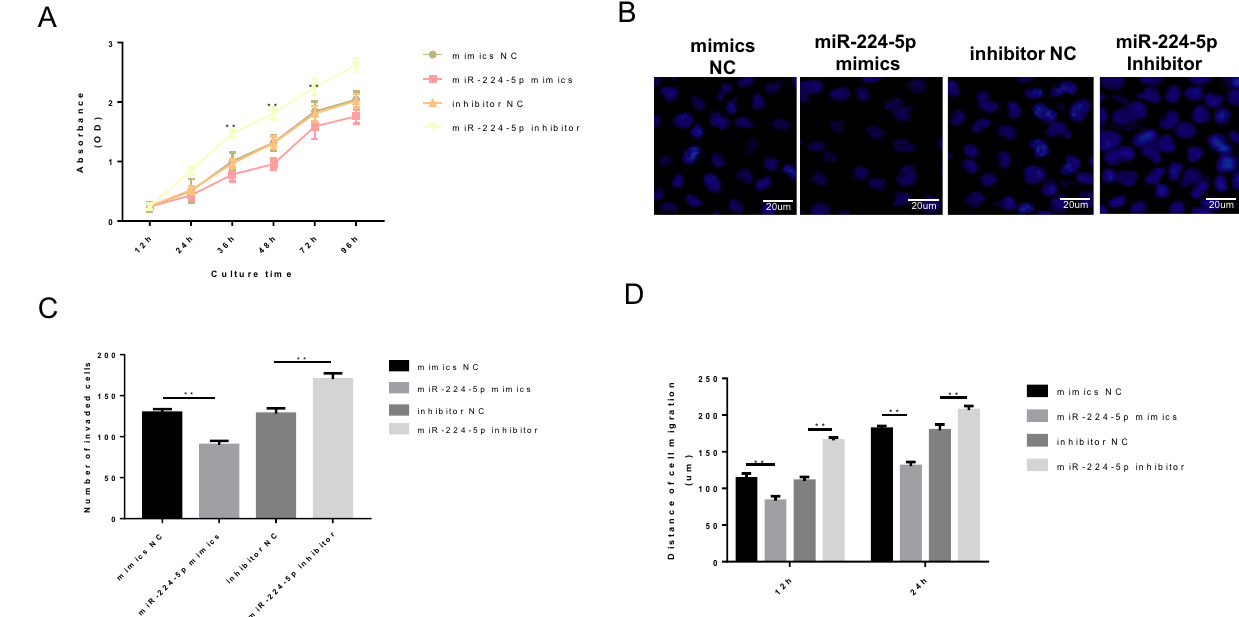
Figure 3. miR-224-5p inhibited the proliferation, migration and invasion of osteosarcoma cells via downregulating Rab10. ( A ) Cell proliferation was tested by the Cell Counting Kit-8 assay. ( B ) Cell invasion was detected by the Transwell assay. ( C ) Number of invading cells. ( D ) Cell migration was detected by the wound healing assay. Rab10 Ras-related protein 10, UTR untranslated